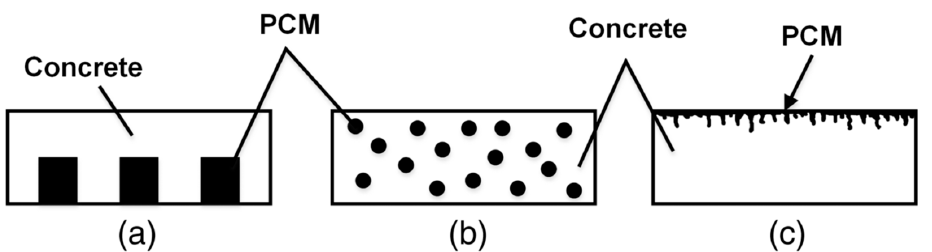
Figure 9. Schematic illustrating three methods of incorporating PCM into concrete: ( a ) using pipes of PCM; ( b ) using particles containing PCM; ( c ) filling concrete surface voids via PCM absorption [123].